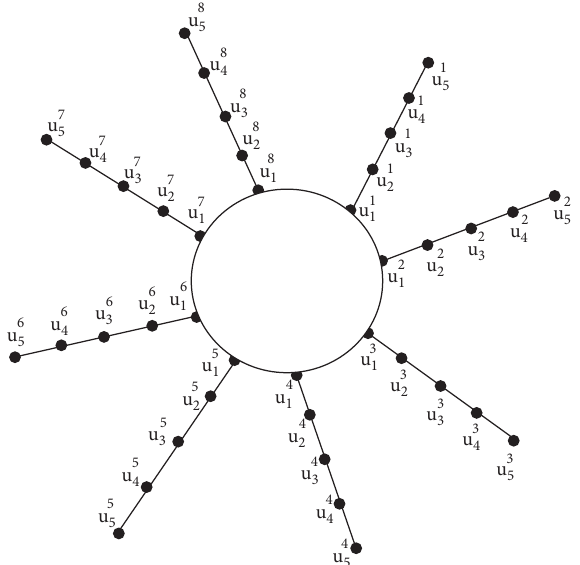
Figure 1: Example of the rooted product graph C